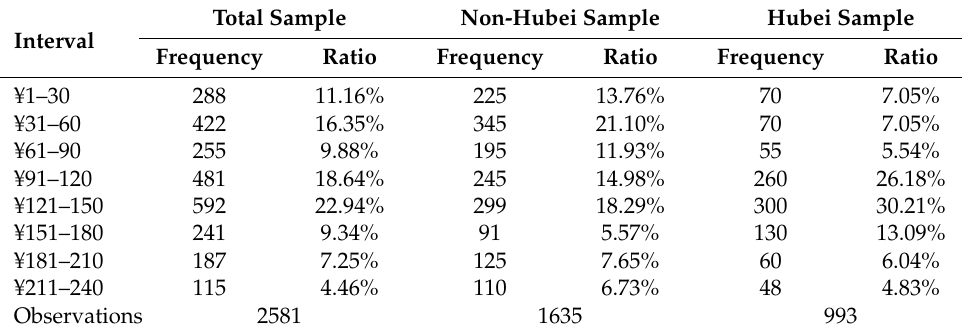
Table 9. Distribution of residents’ WTP value.